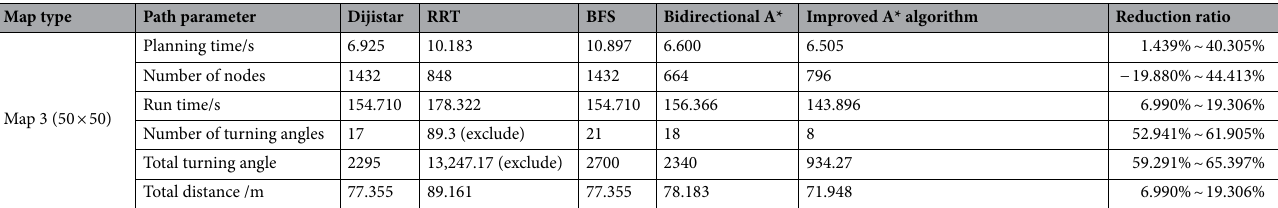
Table 4. Comparison of different algorithm